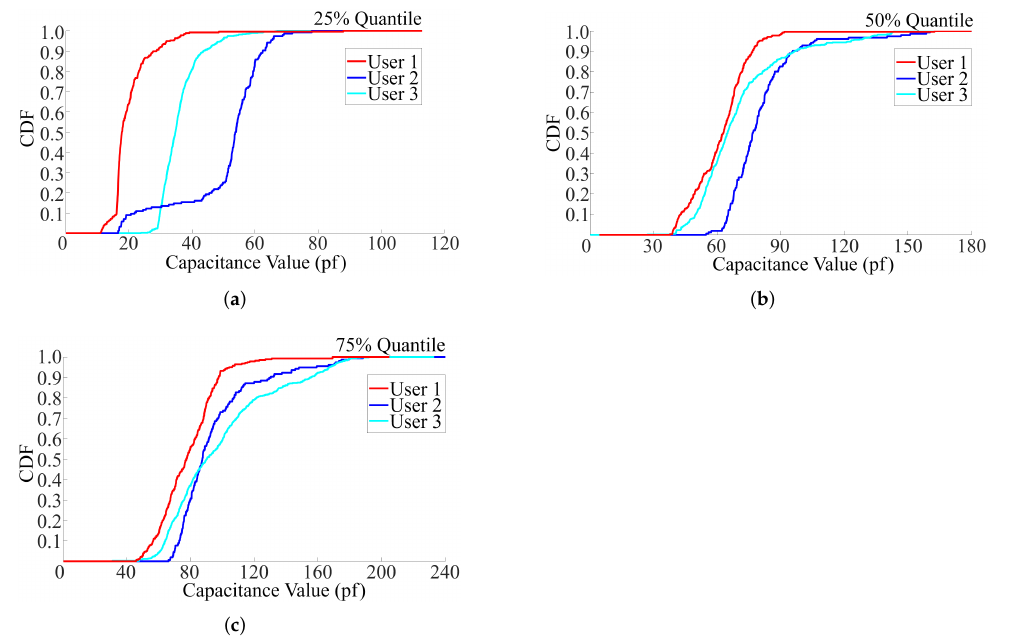
Figure 5. CDF of 25% ( a ), 50% ( b ) and 75% ( c ) quantiles based box plot of the collected data in